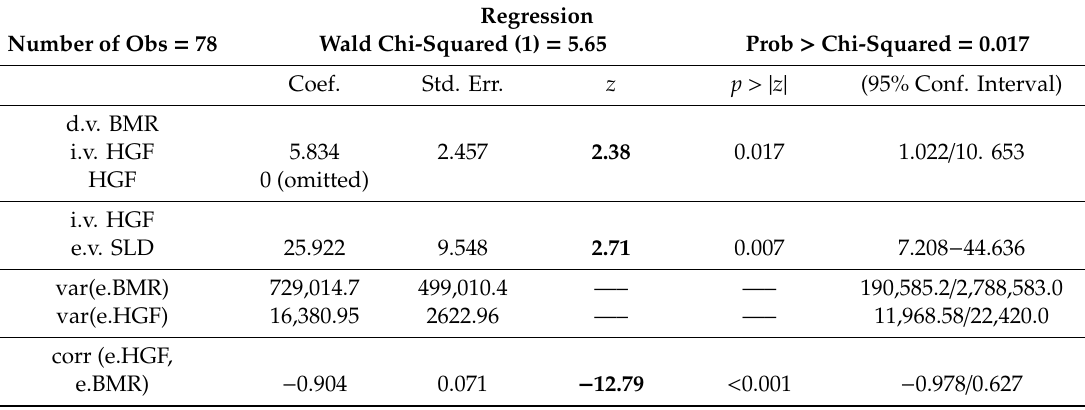
Table 7. Evaluation of the influence of HGF levels in predicting BMR by SLD. Regression